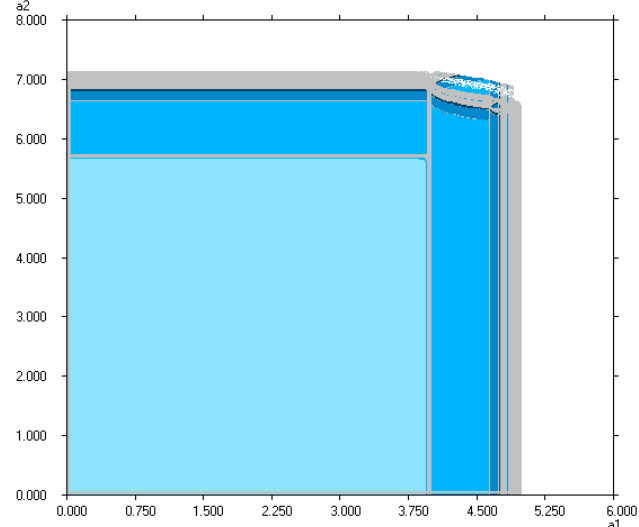
α α and . 1 2 α A A and r with respect to 1 . The 3.99 α < 1 , and . Researchers can